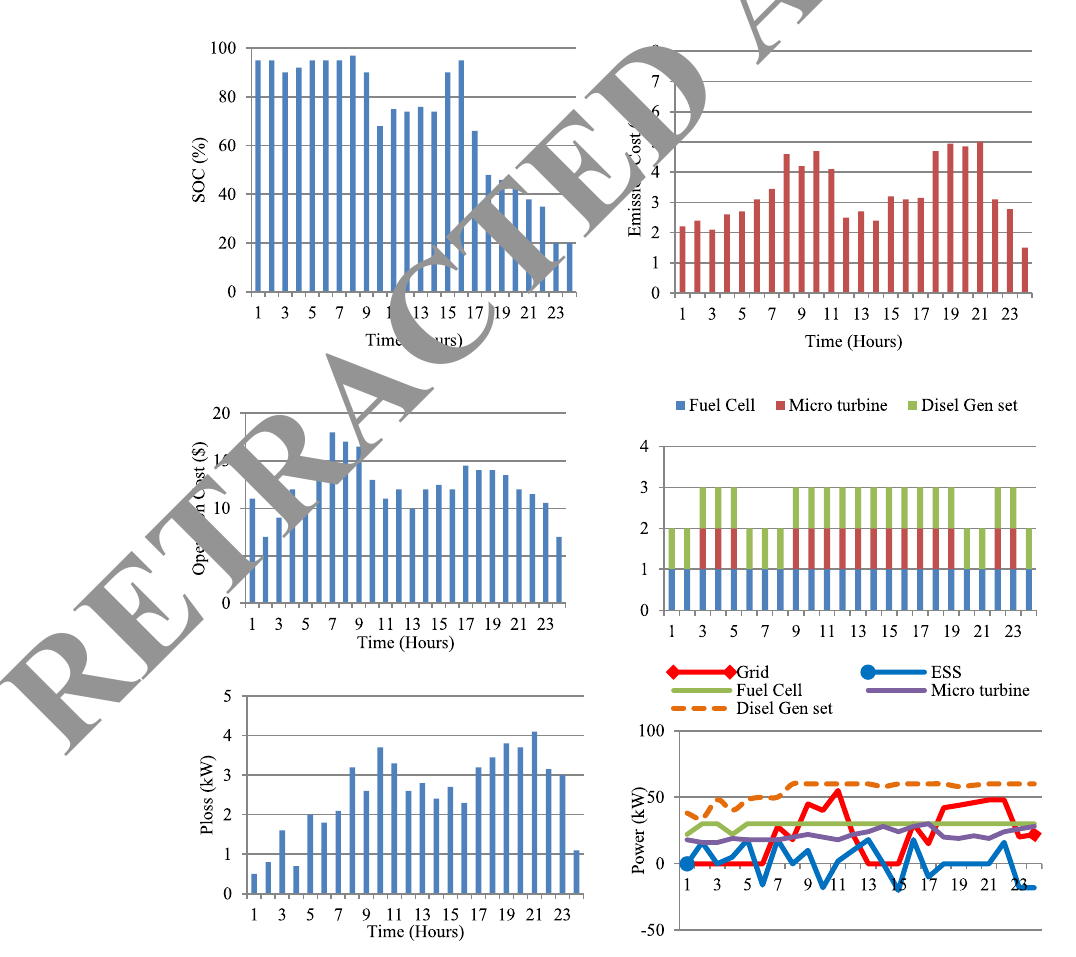
Fig. 5 Simulation results for MGEM in using global